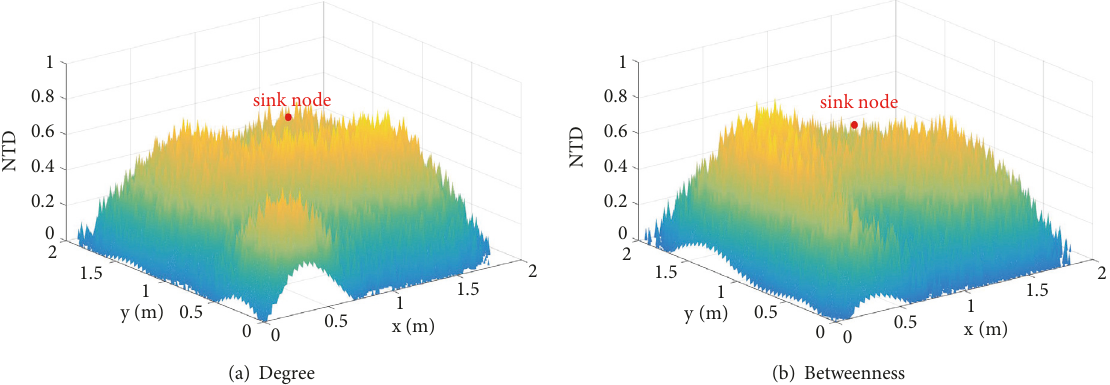
Figure 5: Network traffic distribution (NTD) generated by the degree-based and betweenness-based cascading models, respectively.